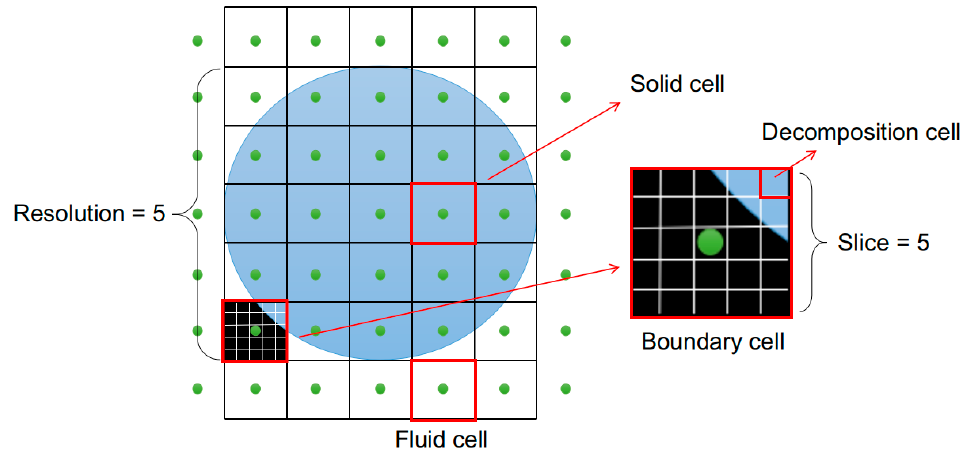
Figure 2. A two-dimensional circular particle mapped on a two-dimensional lattice. Boundary cells on the lattice are then sub-divided into decomposition cells. on the lattice are then sub-divided into decomposition